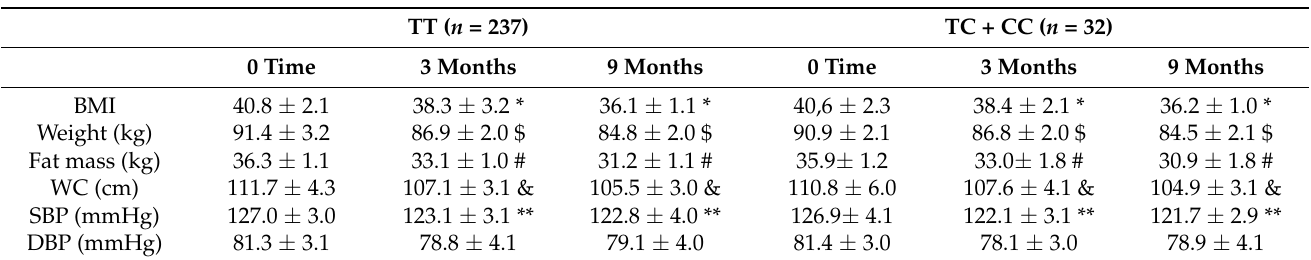
Table 2. Adiposity parameters and pressure at three times (basal and 3 and 9 months after the intervention) (mean ±